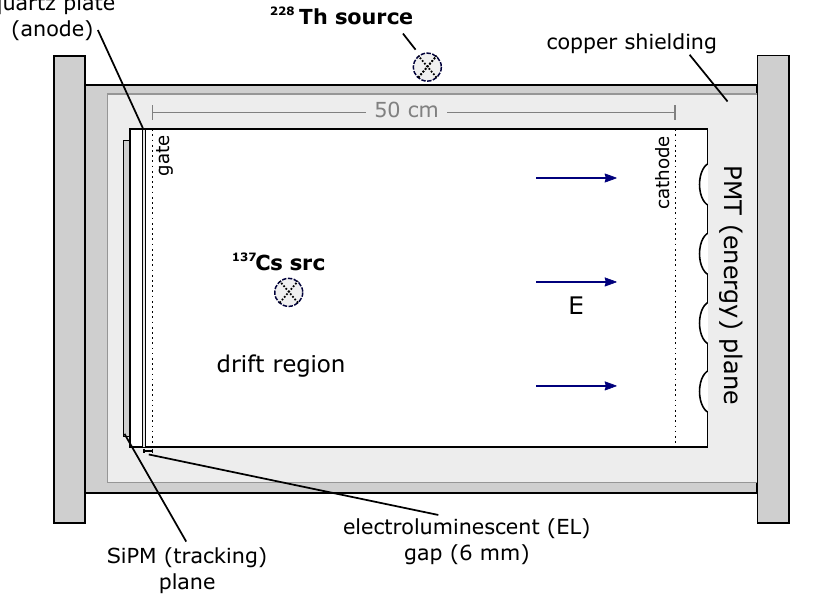
Figure 2 . Schematic of the NEXT-White TPC, showing the positioning of the calibration sources ( 137 Cs and 228 Th) present during data acquisition for this study (figure derived from